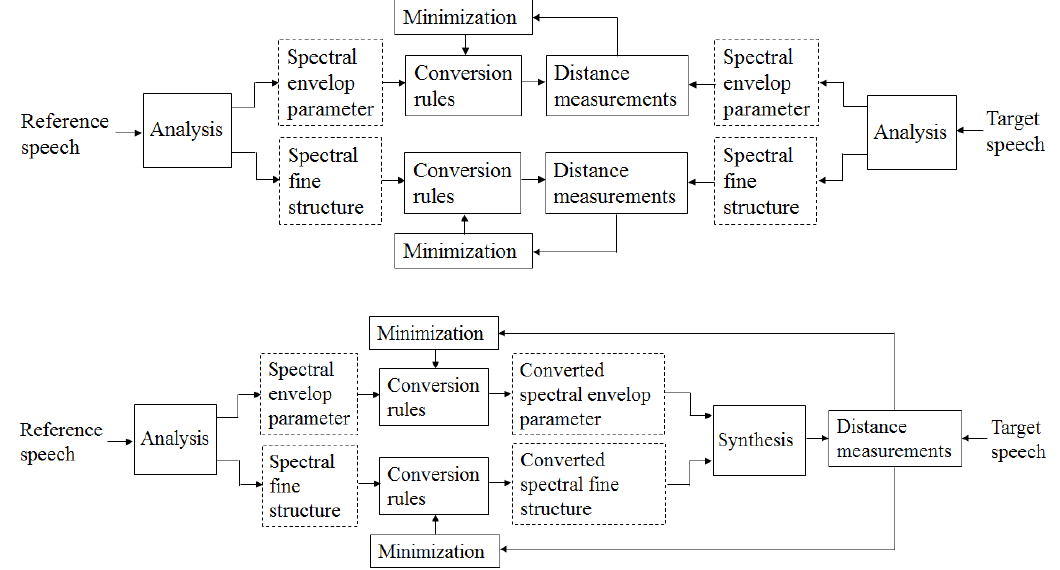
Figure 1. The block diagrams of the two voice conversion (VC) schemes. Top: Conventional VC scheme. Bottom: Proposed VC